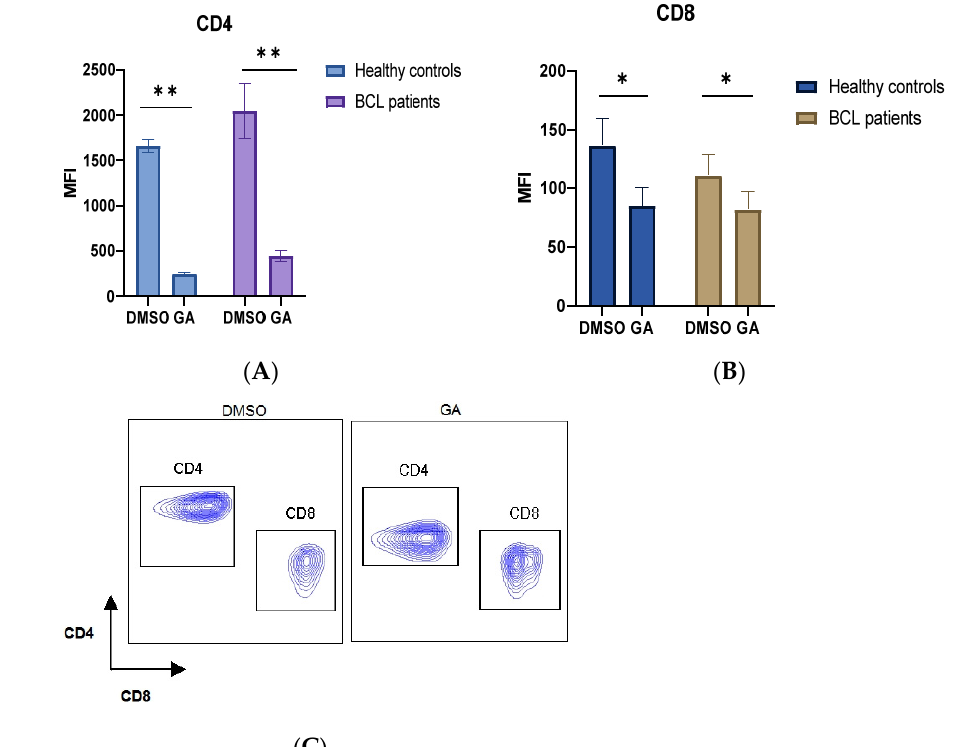
Figure 2. HSP90 inhibition downregulates CD4 and CD8 surface expression. HSP90 inhibitor downregulates surface expression of CD4 ( A ) and CD8 ( B ). T cells were incubated for 4 days with allogeneic mo-DCs in the presence or absence of 0.1 µM geldanamycin (GA). ( C ) Representative flow cytometry plots showing downregulation of CD4 and CD8 molecules on the surface of T cells in response to GA in MLR. Data are presented as mean ± SEM. * p <0.05, ** p < 0.01.